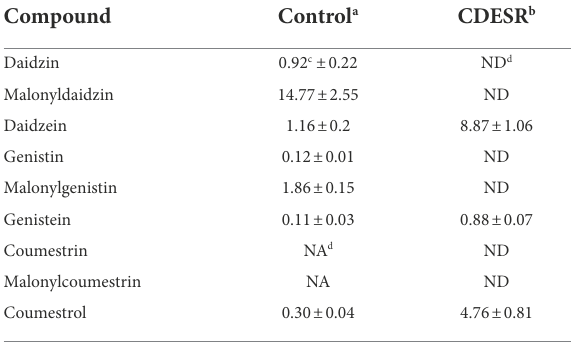
TABLE 1 Contents (mg/g DW) of dietary phytoestrogens in soybean roots. Compound Control a CDESR b